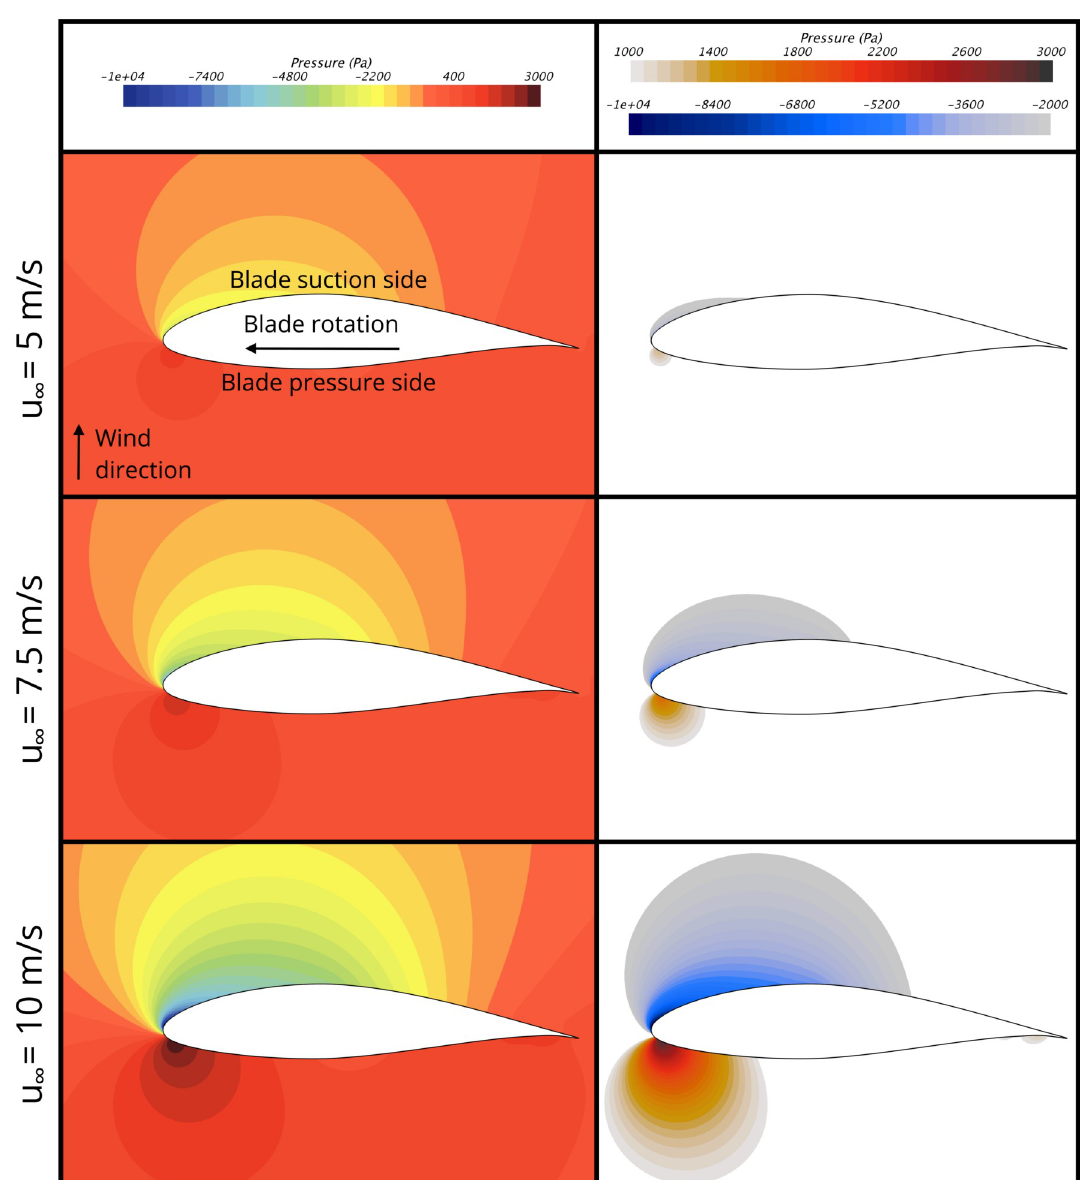
Fig 6. Blade surface pressure for wind speeds of 5 m/s, 7.5 m/s, and 10 m/s. (Left frames) Full-field pressure contours. (Right frames) Pressure contours showing regions of the pressure field where the pressure is lower than -2000 Pa and higher than 1000 Pa, with respect to atmospheric